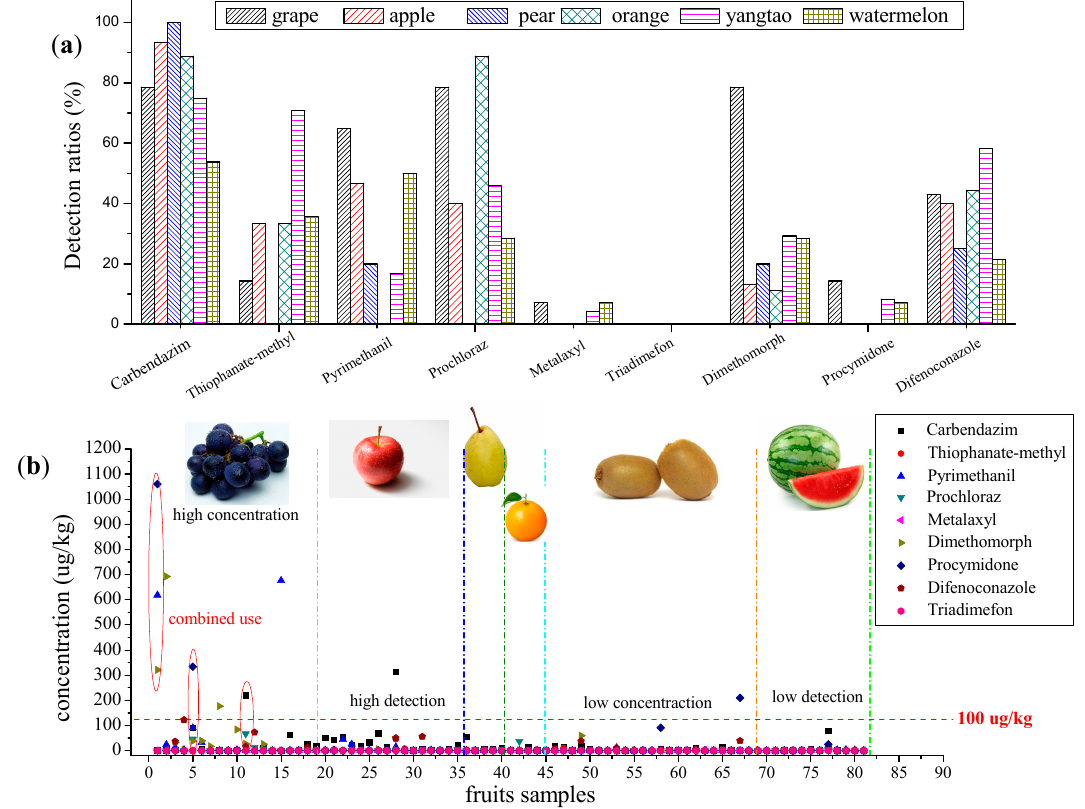
Figure 6. ( a ) Detection ratios of nine fungicides in 81 fruit samples; ( b ) detection concentrations of fungicides in 81 fruit samples.